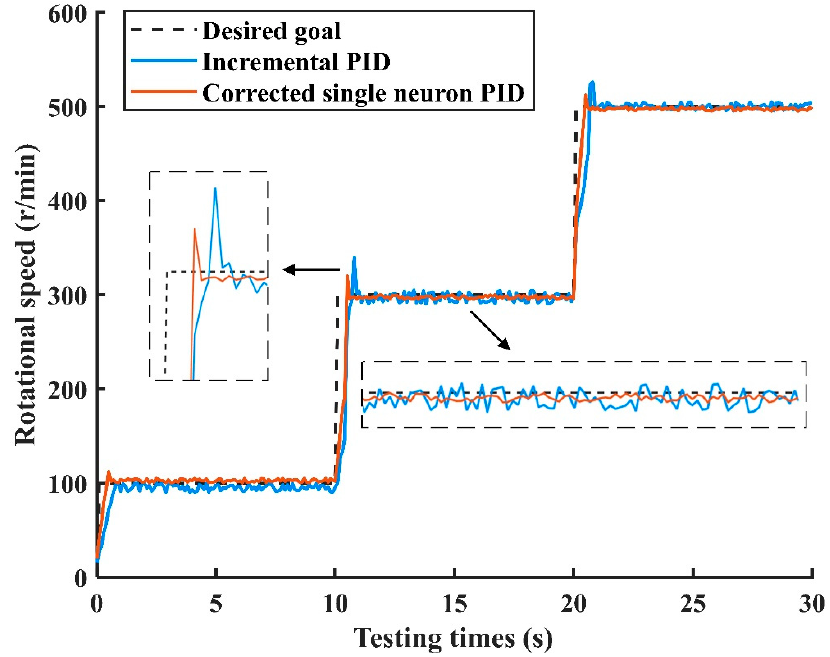
Figure 10. Response curve of continuous variable fertilizer application test. Table 6. Error analysis of dynamic changes in spreading